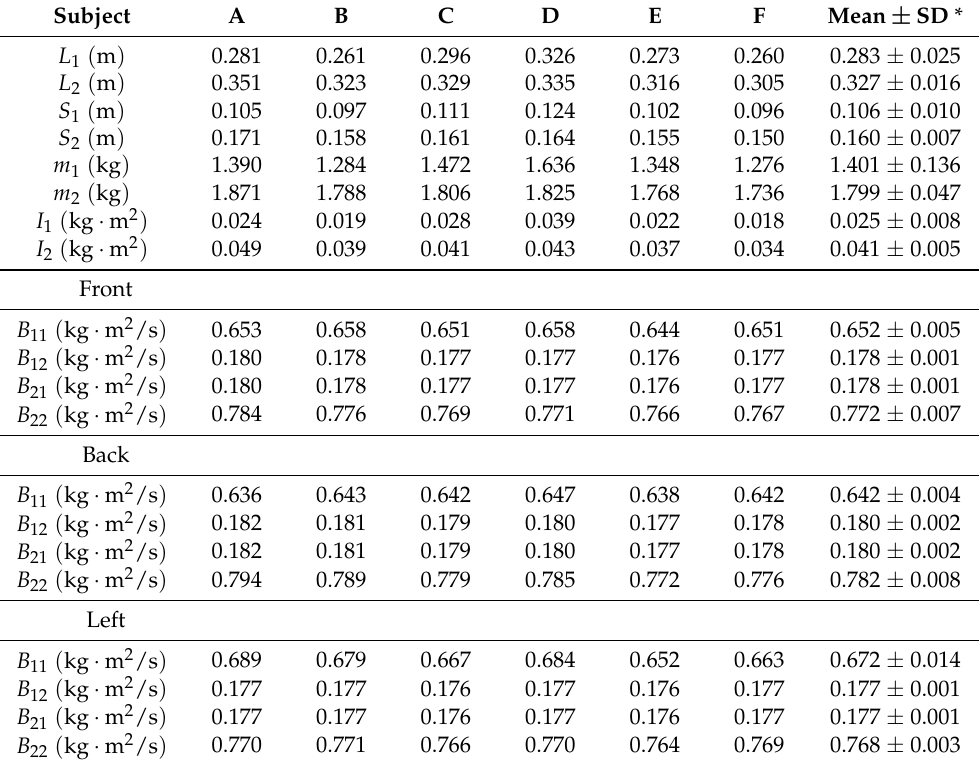
Table 1. Parameters of the arm dynamic model. L 1 and L 2 are the length of the upper arm and forearm, respectively. S 1 and S 2 are the length from the shoulder and elbow joints to the center of gravity, respectively. m 1 and m 2 are the masses of the upper arm and forearm, respectively. I 1 and I 2 are the moments of inertia around the shoulder and elbow joints, respectively. B 11 , B 12 , B 21 , and B 22 are the viscosity coefficient from the joint angular velocity of the right number subscript to the joint torque of the left number subscript. The viscosity coefficient was calculated for each movement